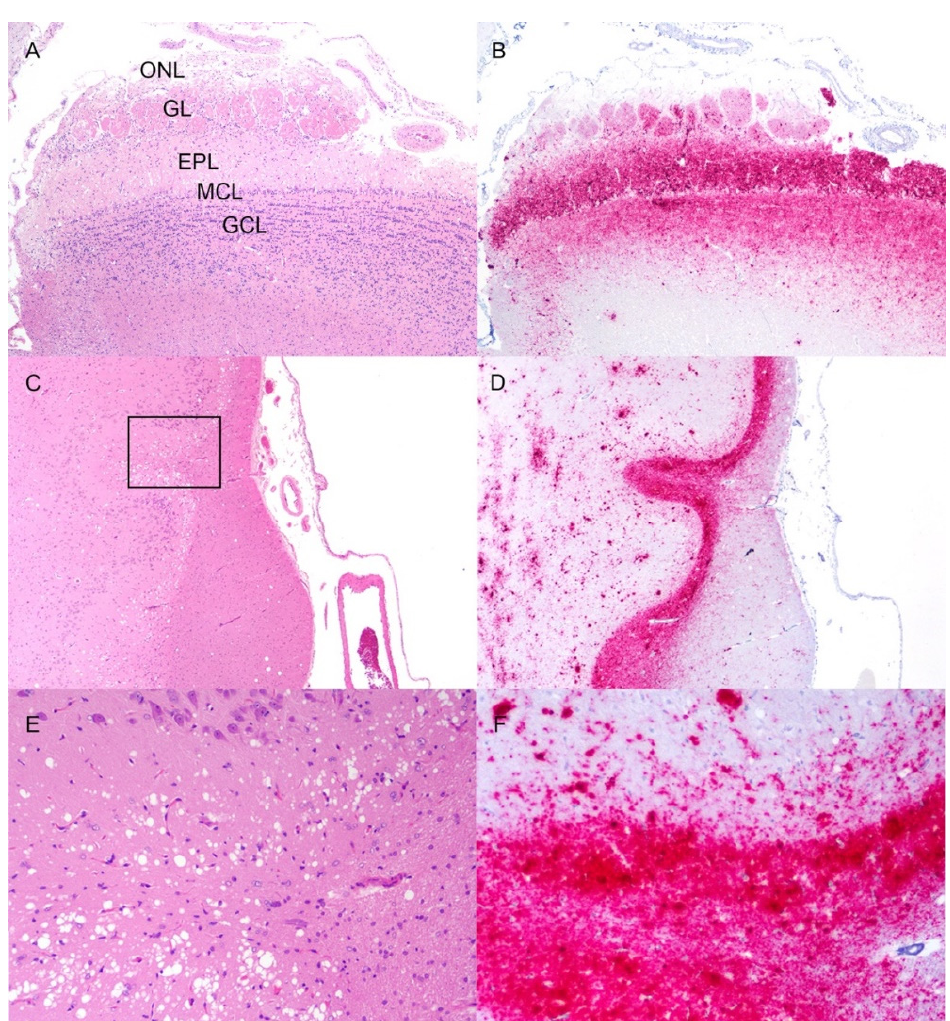
Figure 4. Immunolabeling of PrP Sc in the olfactory pathway of white-tailed deer inoculated with raccoon CWD. ( A ) The layers of the olfactory bulb from rostral to caudal (top of image to bottom) are the olfactory nerve cell layer (ONL), the glomerular layer (GL), the external plexiform layer (EPL), the mitral cell layer (MCL), and the granule cell layer (GCL). Spongiform change is present in the EPL and less notably in the granule cell layer. ( B ) Immunolabeling for PrP Sc (red) is strongest in the EPL and GCL. ( C , D ) The optic tract at the level of the basal nuclei has dense accumulation of PrP Sc (red). ( E , F ) A higher magnification of the area outlined by the rectangle in ( C ). ( E ) There is severe spongiform change in the piriform cortex. ( F ) There are coalescing granular and plaque-like aggregates of PrP Sc in the olfactory tract (red). ( A , C , E ) Hematoxylin and eosin. ( B , D , F ) Immunohistochemistry, F99 monoclonal antibody. Original magnification ( A – D ) 20 × ; ( E , F ) 100 × .